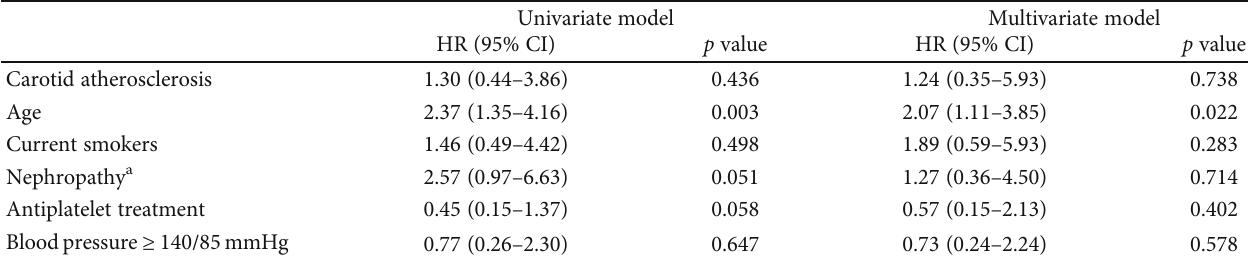
Table 3: Factors associated with new cardiovascular events in patients with prior cardiovascular